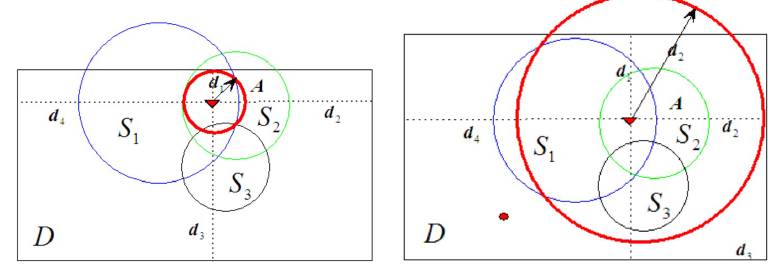
Fig. 12 Schematic diagram of radius selection for escaping